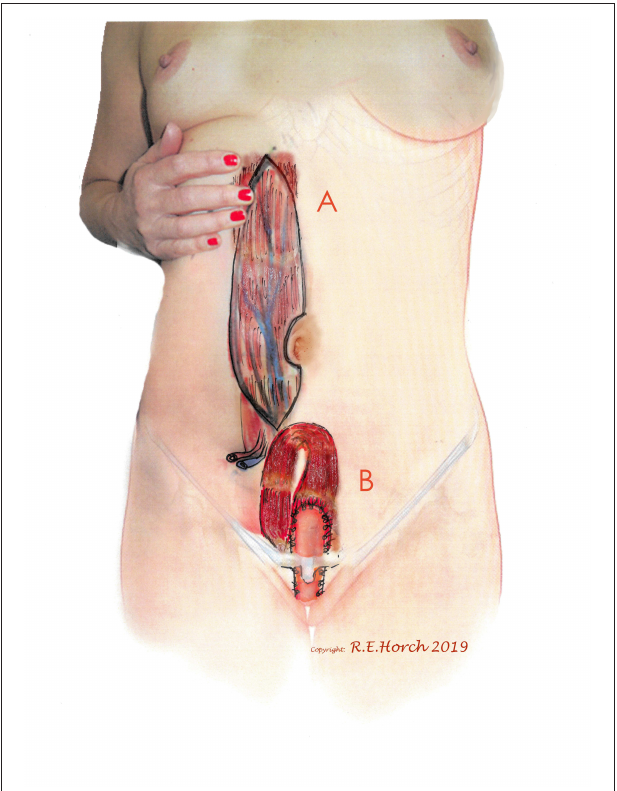
FIGURE 1 | (A) Vertical rectus abdominis myocutaneous (VRAM) Flap preoperatively outlined on standing female patient. (B) Planned intrapelvic VRAM flap transposition to reconstruct the posterior vaginal wall.